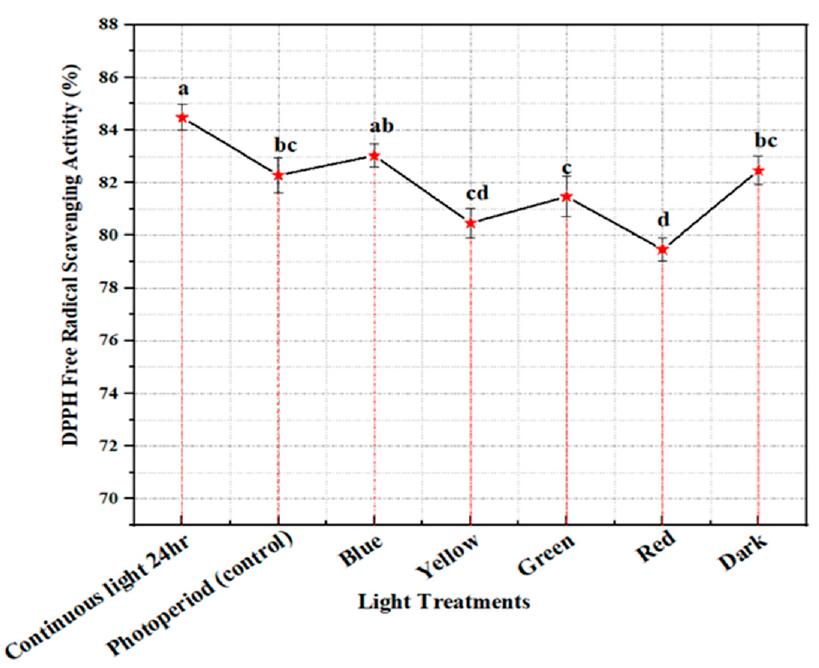
Figure 5. DPPH free radical scavenging activity of in vitro callus cultures of M. oleifera under light treatments. The columns with similar letters are not statistically significant at p < 0.05.